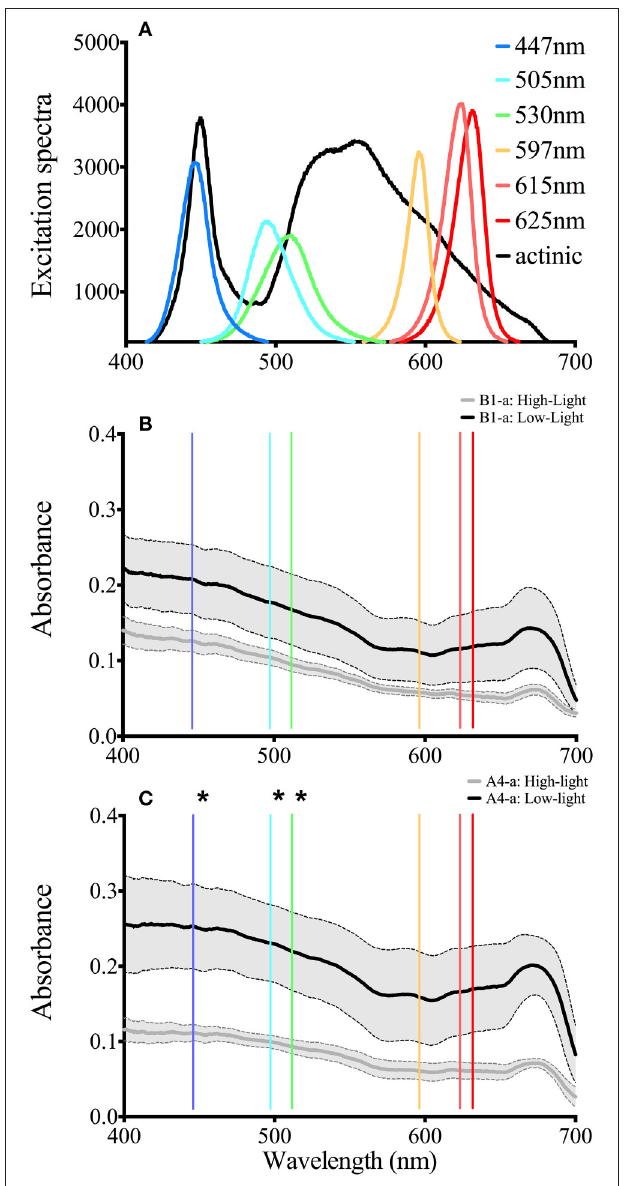
FIGURE 5 | LED output and whole anemone absorption Spectra. (A) Spectral characteristics for all six LED as well as the actinic light source. (B) Absorption spectra for the B1 symbiont under low (black) and high (gray) light conditions. (C) Absorption spectra for the B1 symbiont under low (black) and high (gray) light conditions. The solid line represents the average value and the gray area bounded by the dotted lines represent the standard deviation. Asterisks represent significant differences between low and high light conditions at the specific wavelengths.